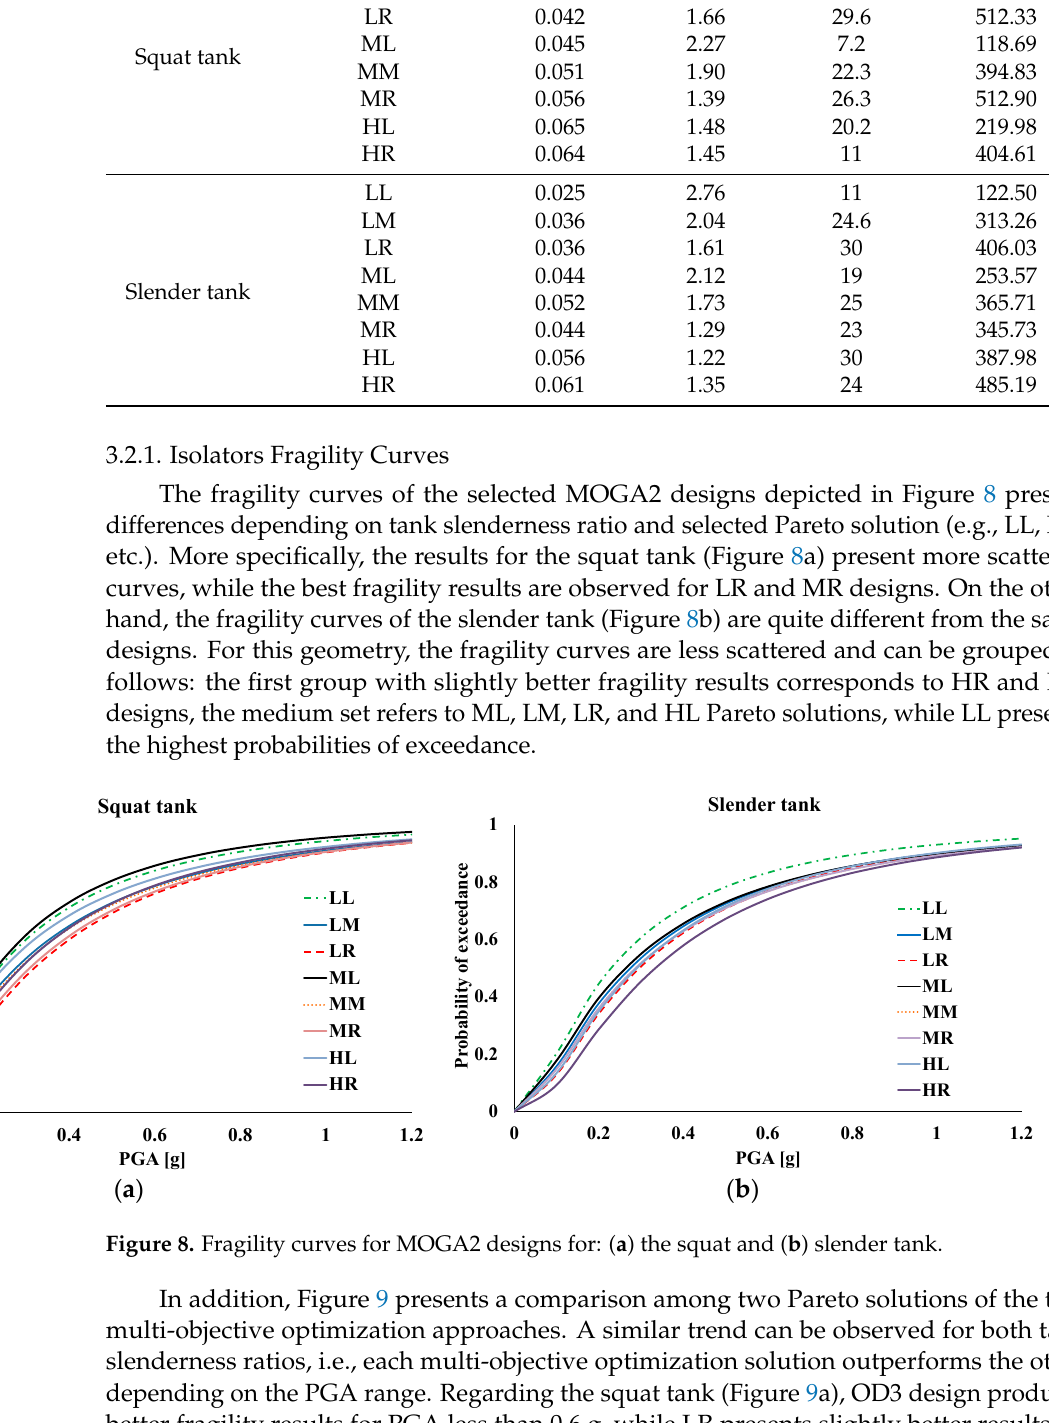
Table 4. Optimization results for the selected solutions of the MOGA2 approach.